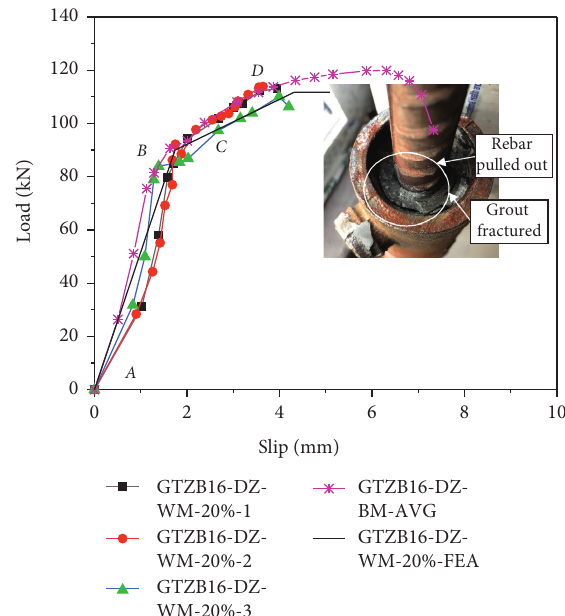
Figure 12: The load-slip curves of the insufficient compactness specimen (AVG: average value; FEA: finite element analysis).